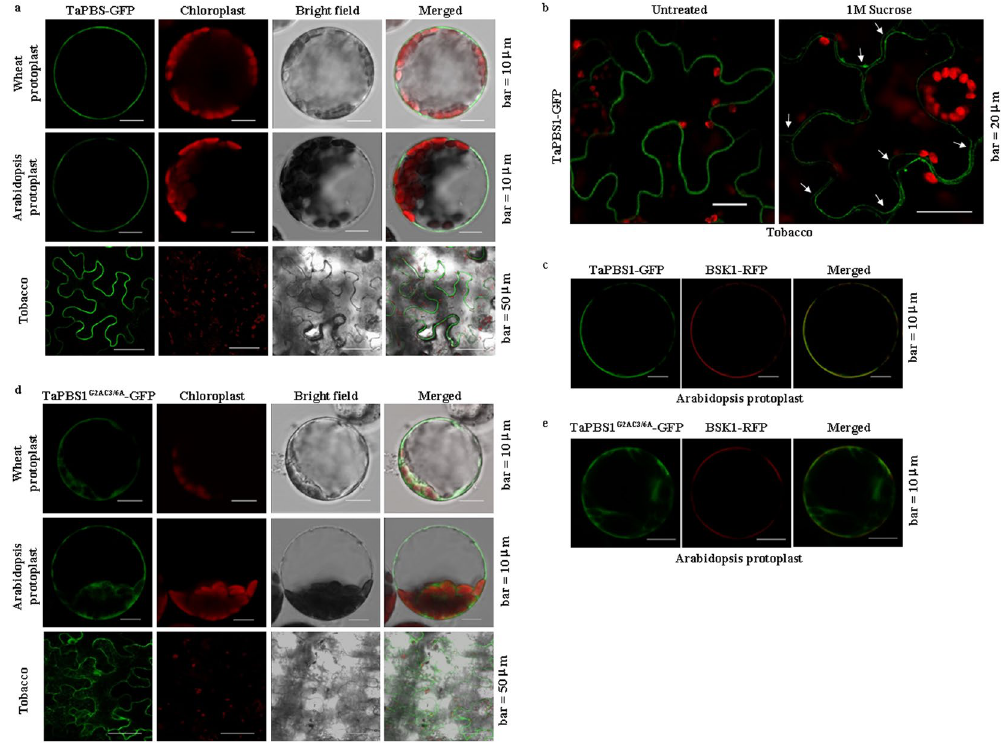
Figure 4. TaPBS1 is localized to the plasma membrane. ( a ) The subcellular localization of TaPBS1 in Arabidopsis protoplasts, wheat protoplasts, and N . benthamiana leaves. TaPBS1 was transiently expressed in wheat protoplasts, Arabidopsis protoplasts or N . benthamiana leaves, and then subjected to laser confocal imaging. Chloroplasts were visualized with the autofluorescence of chlorophyll. ( b ) The plasmolyzed N . benthamiana epidermal cells expressing TaPBS1-GFP (arrows) demonstrated the PM localization of TaPBS1. N . benthamiana leaves infiltrated with A . tumefaciens carrying the TaPBS1-GFP construct were mounted in 1 M sucrose. ( c ) TaPBS1-GFP is co-localized with BSK1-RFP, a PM-localized fusion protein, at the PM. ( d ) Alanine substitutions of predicted myristoylation (glycine-2) and palmitoylation (cysteine-3/6) residues affected the PM localization of TaPBS1. TaPBS1 G2AC3/6A -GFP was transiently expressed in wheat protoplasts, Arabidopsis protoplasts or N . benthamiana leaves. ( e ) Co-localization analysis of TaPBS1 G2AC3/6A -GFP and